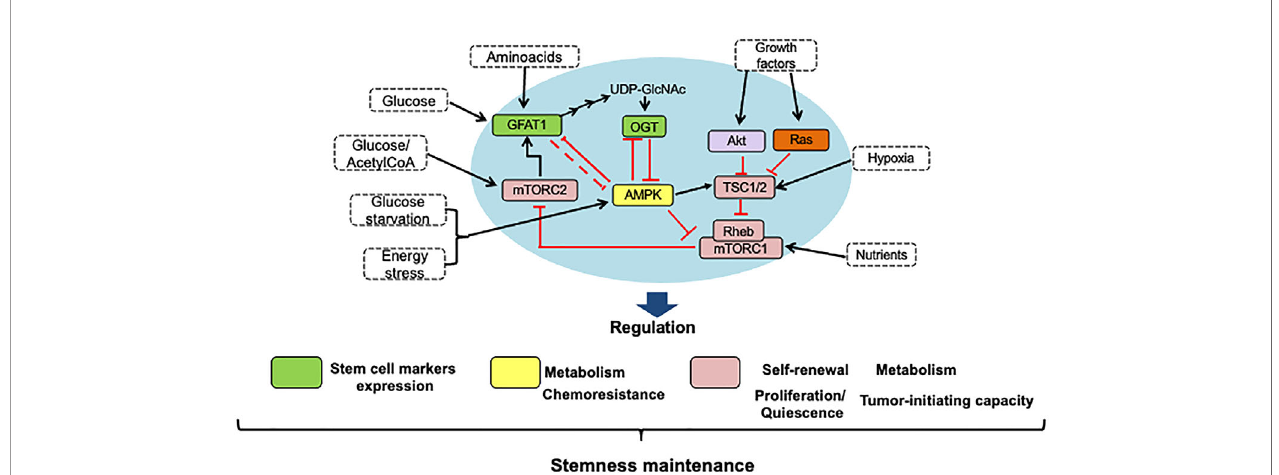
FIGURE 6 | HBP, mTOR, and AMPK signaling pathways interaction is crucial to stemness maintenance. Using nutrient-sensing pathways such as HBP, mTOR, and AMPK, stem cells respond to nutritional cues, and the crosstalk between them is key to maintaining stemness. Thus, to regulate the maintenance of stem cells in the tumor microenvironment, conditions such as the availability of nutrients, growth factors, and oxygen can modulate energy maintenance through the activation and inhibition of master proteins of these pathways. The self-renewal of stem cells has been shown by an increase in the expression of stem cell markers like CD44 or CD133 and an increase in the ability to resist chemotherapeutic drugs, which maintains the survival of these cells within the tumor. In the blue circle, the main proteins that allow the interaction between these pathways are